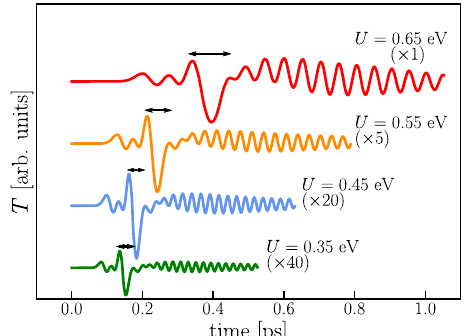
Fig. 7 Control of temperature wave-like oscillations. Temperature T ( t ) of the “ cold ” electronic oscillation at the n = 15 layer for different values of U (the same values used in the inset of Fig. 4) Some of the data have been magni fi ed and the curves shifted for graphical reasons. The horizontal arrows highlight the oscillation periods that match the frequency ν * extracted from spectral analysis of the temperature wave